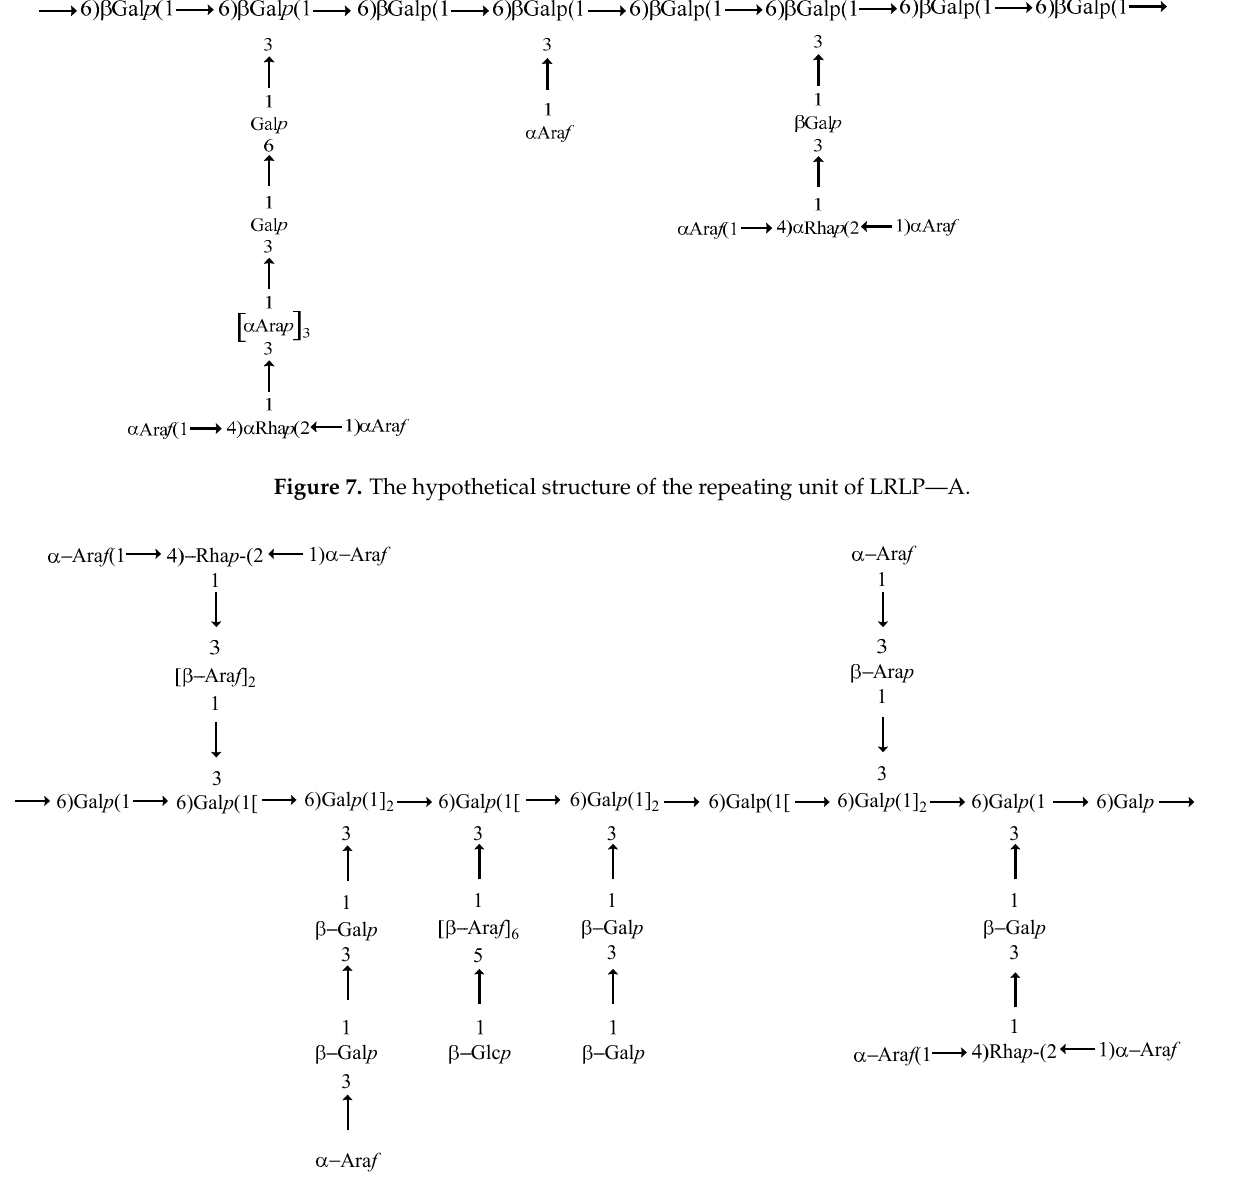
Figure 9. The presumptive structure of a homogeneous polysaccharide, LBP-W.